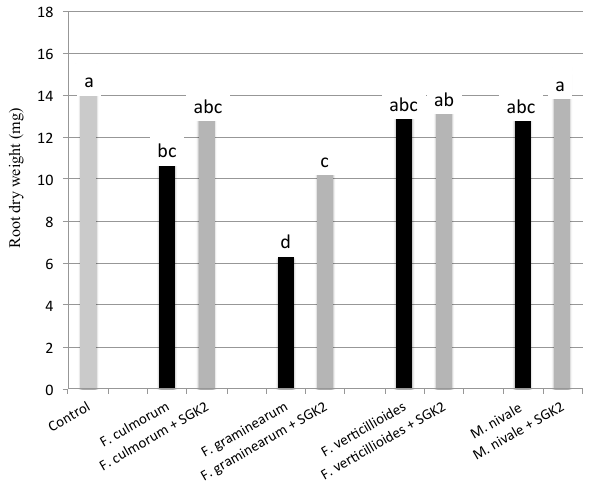
Figure 3. Effects of inoculation with Paenibacillus polymyxa SGK2 on root growth of durum wheat inoculated with four fungal species, as measured by mean root dry weight. Durum wheat was either infected by the fungal pathogens (black bars), or inoculated by the fungal pathogen and the P. polymyxa SGK2 strain (grey bars). Values accompanied by different letters are significantly different according to LSD tests ( P <0.05).